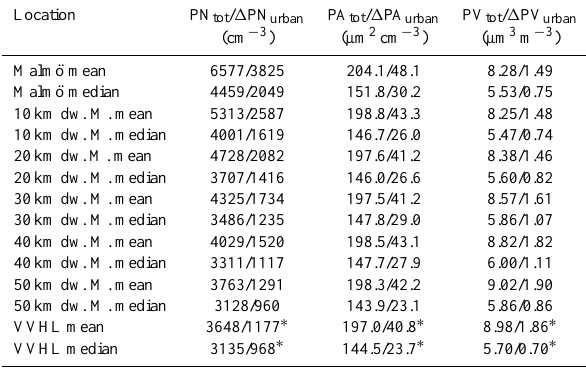
Fig. 5. Estimated average local emission contribution from Malm¨o, in Malm¨o, 10, 20, 30, 40 and 50km downwind of the city. The par- ticle number size distributions were derived by subtracting the mod- eled background particle number size distribution from the modeled particle number size distributions in the center of the urban plume, at different distances downwind of Malm¨o. The result from Vavi- hill was derived by subtracting the measured particle number size distribution at Vavihill when the station was not influenced by the Malm¨o plume from the measured particle number size distribution at Vavihill when the station was influenced by the Malm¨o plume.